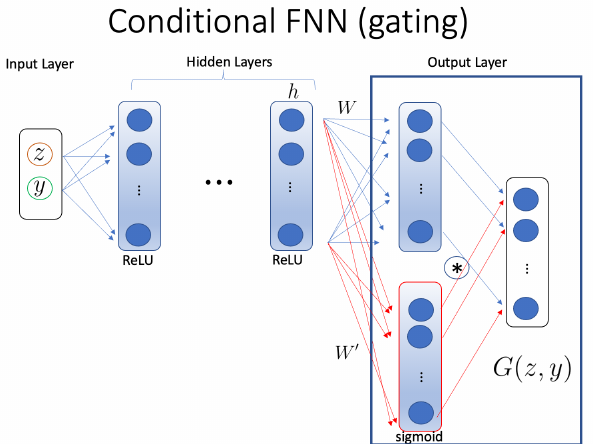
Figure 2. Schematic of how gating is implemented in the Generator architecture of the feed-forward neural network (FNN) conditioned on y . Gating is used to model zero-inflated samples. The output layer is calculated as G ( z , y ) = ( Wh + b ) ∗ σ ( W (cid:48) h + b (cid:48) ) where ∗ stands for element-wise